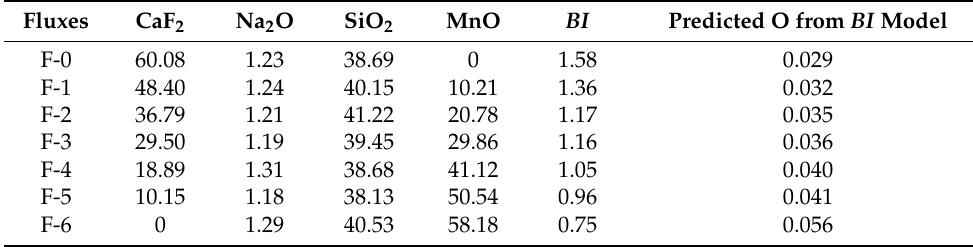
Table 2. Measured compositions of fluxes (wt pct).